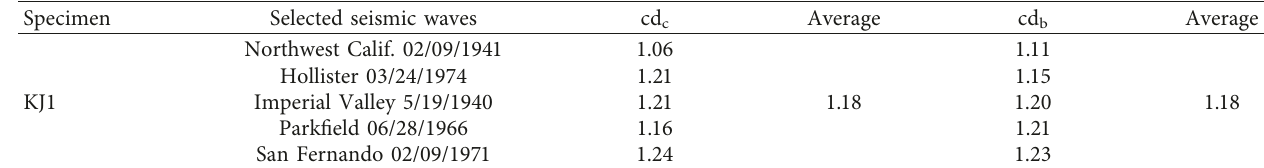
Table 12: Maximum curvature ductility coefficients of beams and columns in model